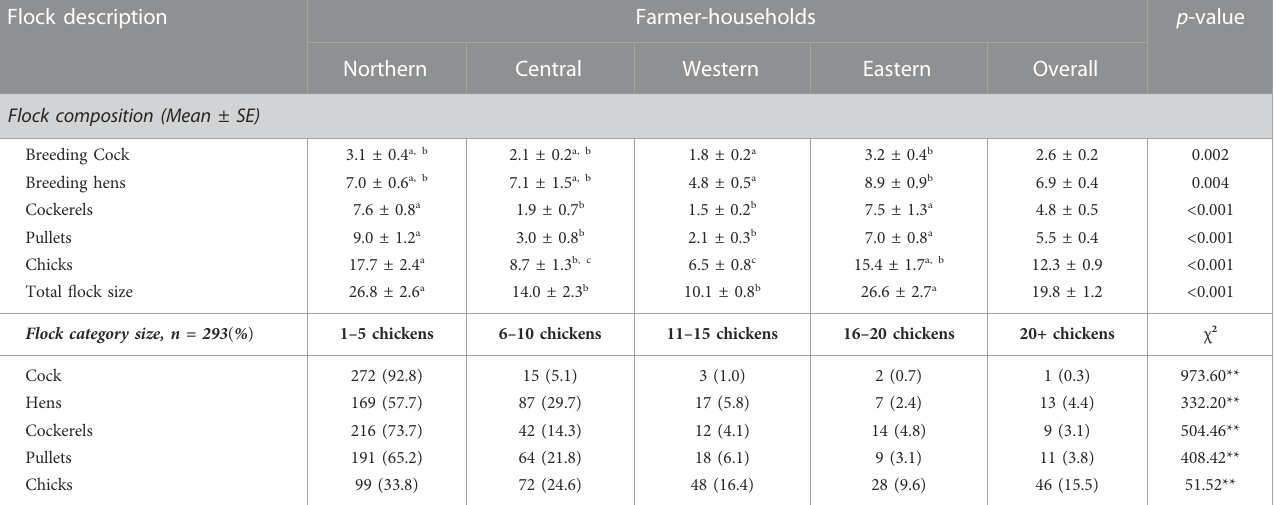
TABLE 2 Composition of household indigenous chicken fl ocks in Uganda.